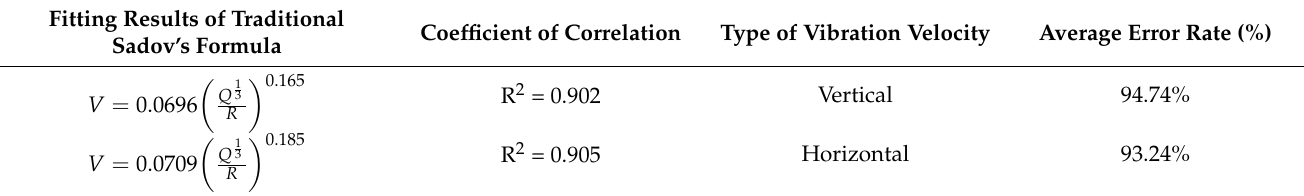
Table 3. The error rates of Sadov (cid:48) s fitting formula.